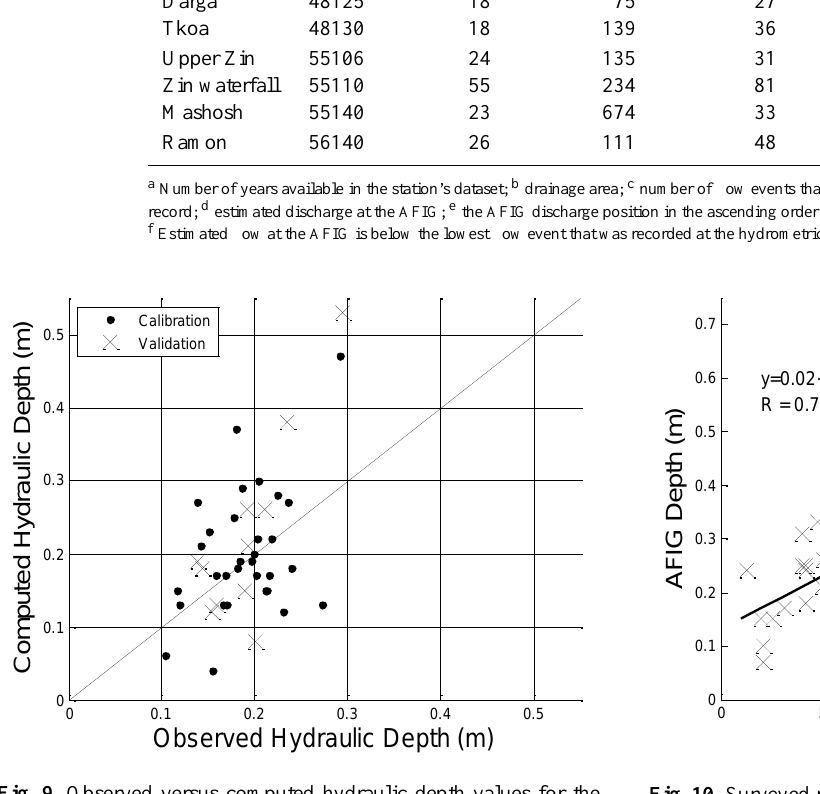
Fig. 9. Observed versus computed hydraulic depth values for the Figure 9. Observed versus computed hydraulic depth values for the calibration and validation calibration and validation datasets. The 1:1 line is shown. datasets. The 1:1 line is shown.